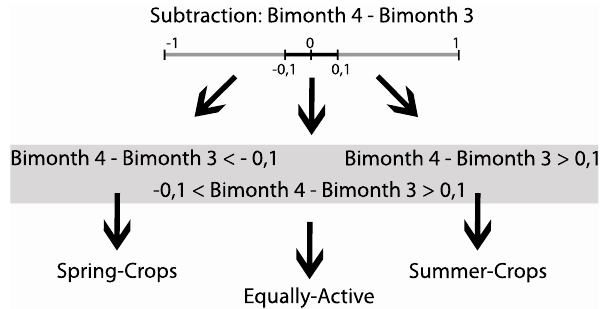
Fig. 5. Decision tree for the differentiation of three phenological categories (spring, summer, equal) using the change signal of two MERIS NDVI images for Bimonth 3 and Bimonth 4